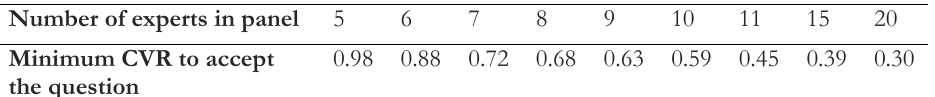
Table 4. Minimum CVR vs number of experts in the panel.